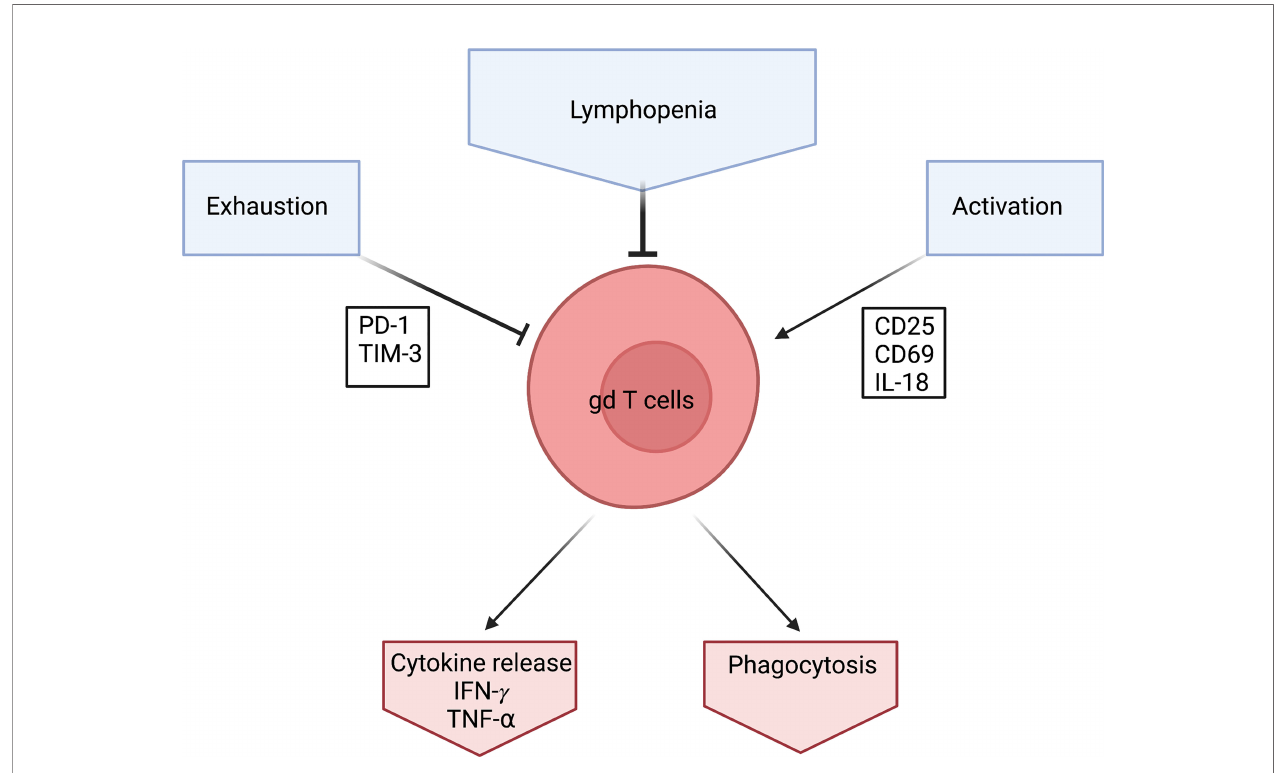
FIGURE 2 | Schematic of what effects gd T cells during a Covid-19 infection. gd T cells levels are low in Covid-19 patients which is characterized by Lymphopenia. They seem to be exhausted which is detected via the exhaustion marker PD-1. They also seem to be heavily activated which is shown through activation markers CD25, CD69 and IL-18. However, gd T cells produce high amounts of IFN- g in response to Covid-19. Created by